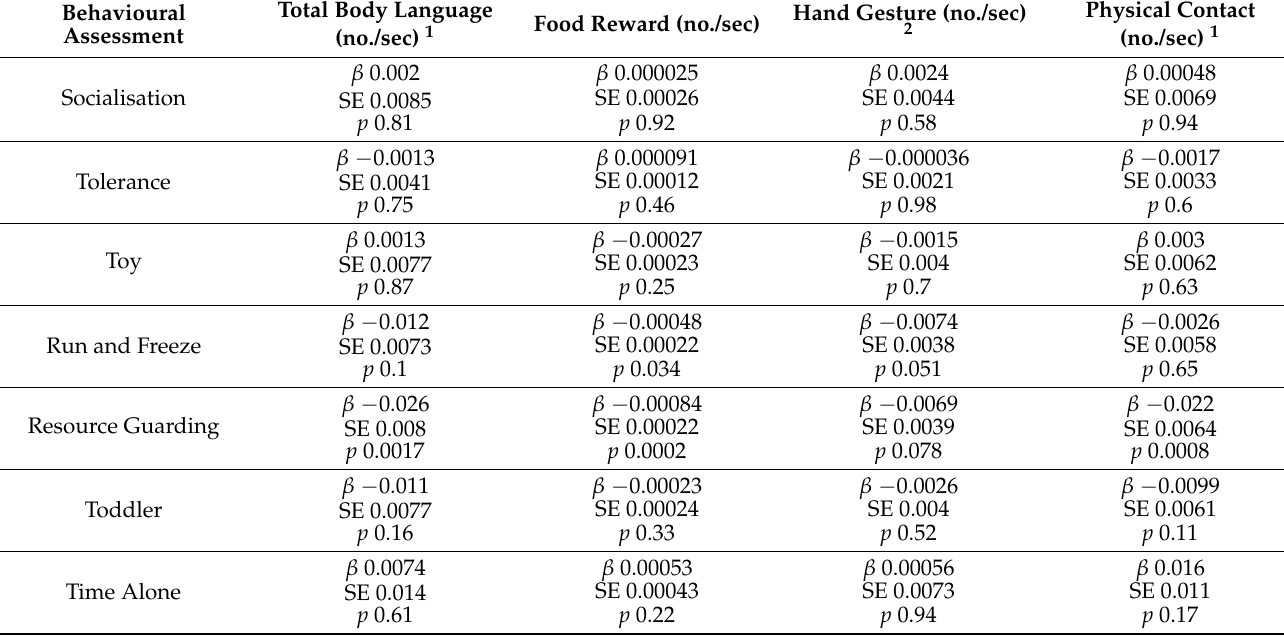
Table 8. Generalised linear mixed model of the effect of canine behavioural assessment on human body language. Behavioural Assessment